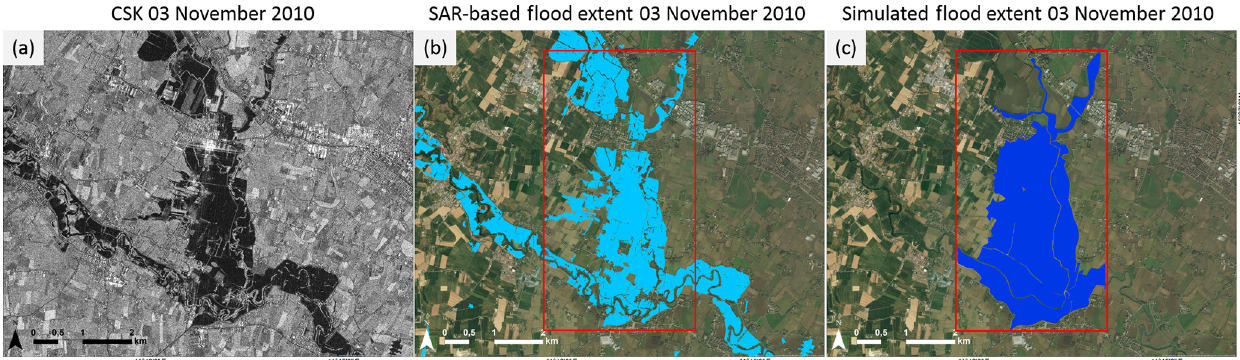
Figure 14. Comparison between SAR-based flood extent and simulated flood extent for the Veggiano area on 3 November. Panel (a) shows the CSK SAR image of 3 November 2010; panel (b) shows the flood extent derived from the SAR image; panel (c) shows the simulated flood extent, which was calculated only for the area delimited by the red box. The difference between the two extents is very